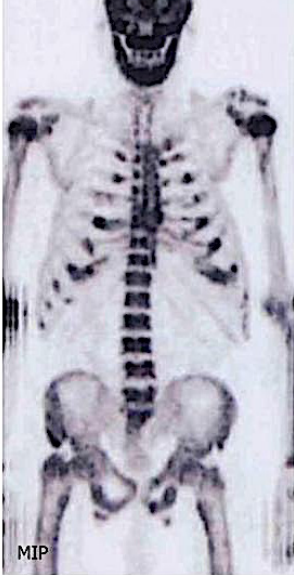
Figure 7. Bone scintigraphy: skeletal uptake of 99m Tc-labelled diphosphonate in a patient with hyperparathyroidism. There is increased bone turnover shown by increased symmetric tracer uptake throughout the skeleton, including calvaria, mandible, humeral head, accentuating the contrast between bone and soft tissue, and a beading pattern at the costochondral junctions.